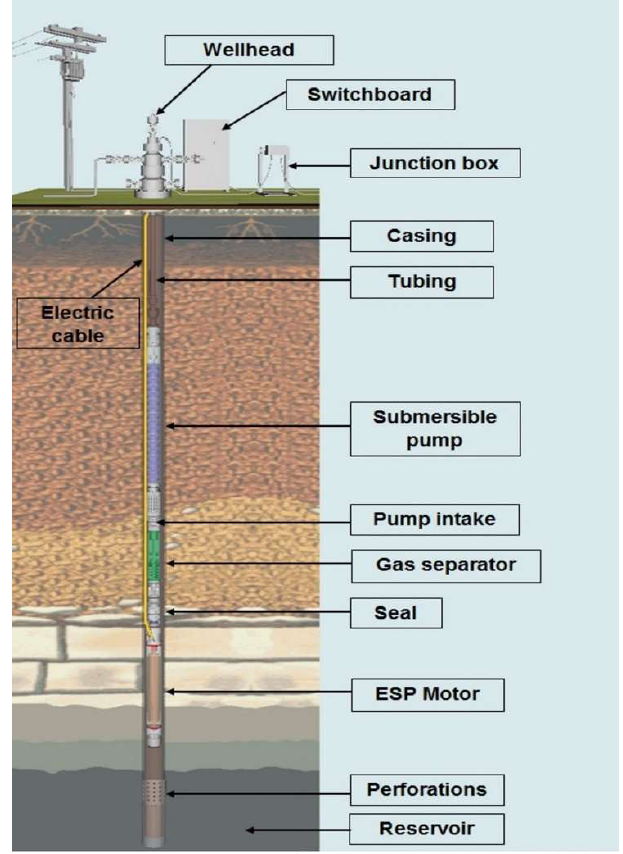
Figure 1. Onshore ESP system